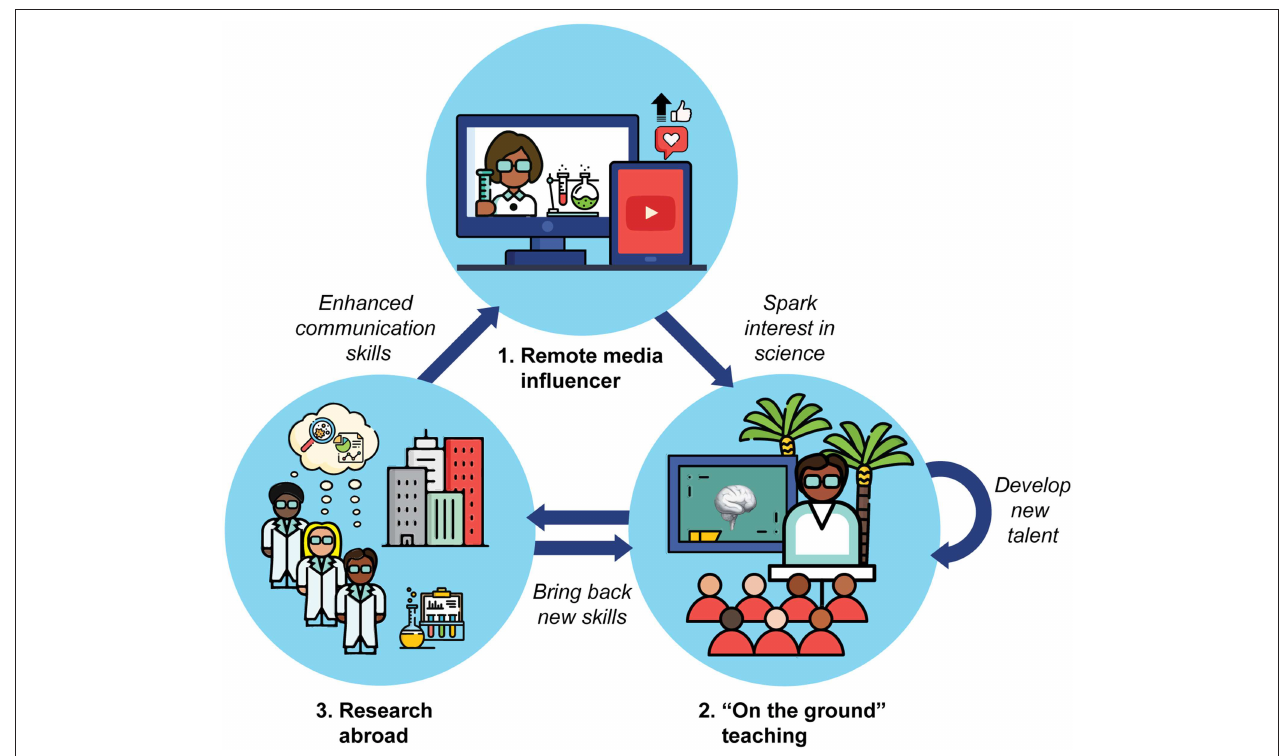
FIGURE 1 | The circle of scientific talent exchange. 1. Scientists from developed nations share scientific methods to drive engagement and aspiration among local students in developing nations. 2. “On the ground” instruction in science, technology, engineering, and mathematics (STEM) by visiting scientists from developed nations, via initiatives like Clubes de Ciencia Bolivia, galvanizes student confidence through first-hand experience and training. Co-instruction with local scientists cultivates a pool of local talent. 3. Experience of local students and alumni increases competitiveness in attaining internships and fellowships at research universities of developed nations, resulting in bilateral transfer of advanced skills and cultural perspectives. Newly trained scientists are incentivized to return home, establishing robust research infrastructure. Growth of a specialized workforce, in concert with domestic policies supporting research institutes in a developing nation, heightens national ranking in STEM. Enhanced science communication skills and social media participation further encourage local students toward STEM, inspiring a new generation of youth in developing countries to start their scientific journey. Importantly, developed nations reciprocally benefit from student exchange initiatives, as international diversity in perspectives and approaches correlates with academic productivity and success in